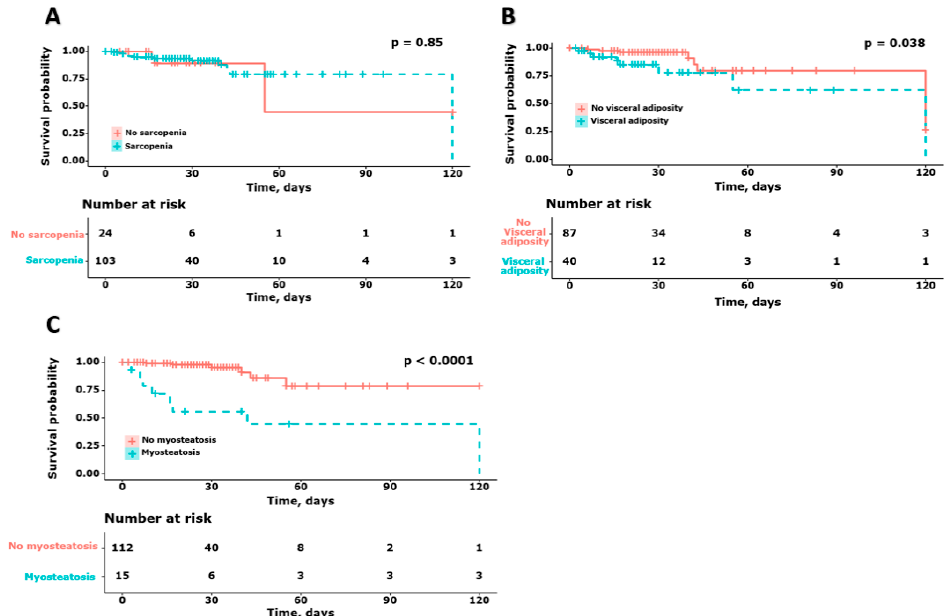
Figure 3. Survival graph according to the presence or absence of sarcopenia ( A ), visceral adiposity ( B ), and myosteatosis ( C ) in patients with COVID-19.